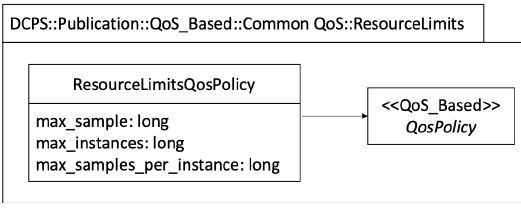
Figure 5. ResourceLimits